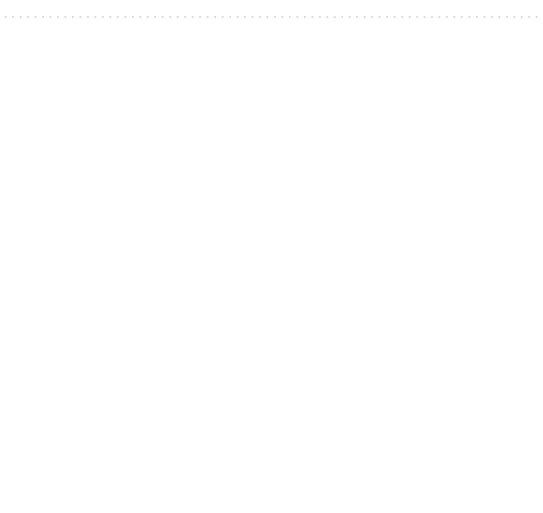
Figure 10. The architecture of a R-CNN + SVM used for feature detection and tracking. All the convolutional layers use 5 × 5 kernels and ReLU as activation functions.